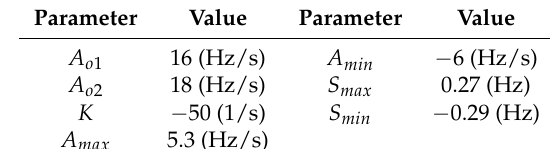
Table 3. MOOST parameter tuning example.